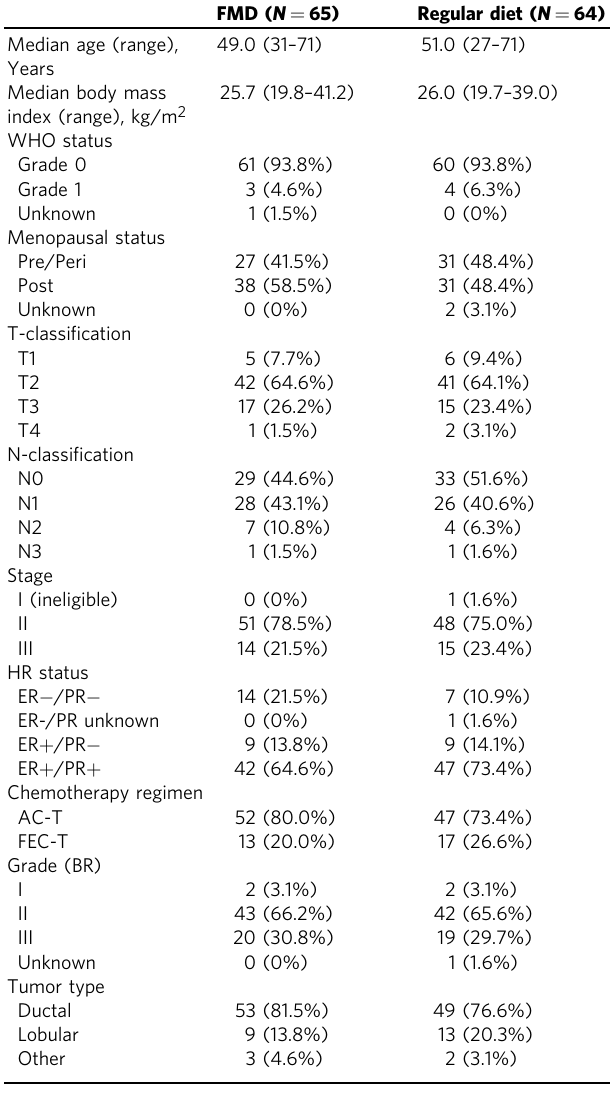
Table 1 Patient